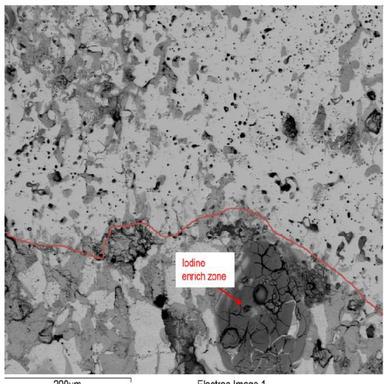
BSE image of the intermediate region microstructure (region 2 in with highlights on an Iodine enrich zone. The red line delimits the intermediate region from the outer region toward the periphery of the fuel. (For interpretation of the references to color in this figure legend, the reader is referred to the Web version of this article.)